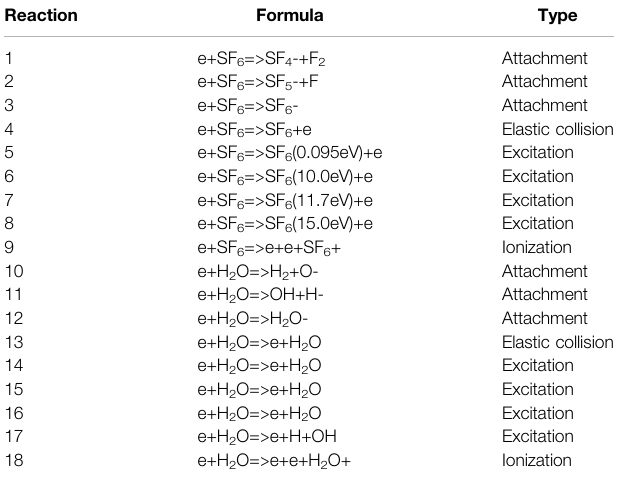
TABLE 1 | Cross-section set of the considered electron collision